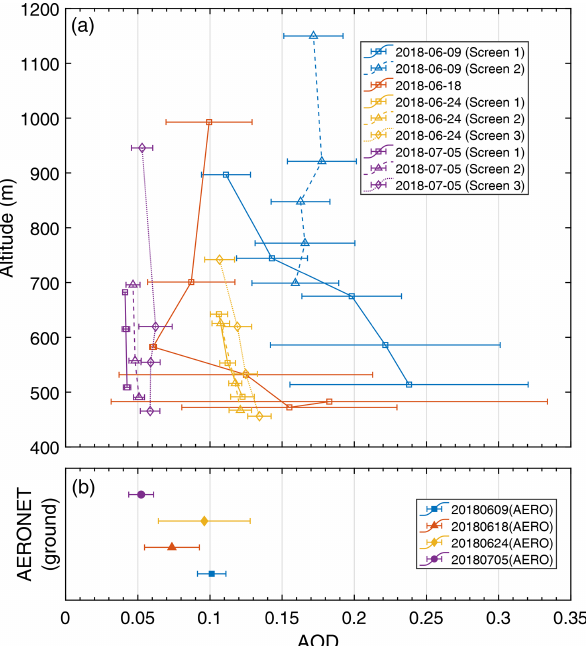
Figure 8. (a) 4STAR in-plume mean fine-mode AODs for transfor- mation flights of 9 and 24 June and 5 July and an emission flight of 18 June. (b) Fort McMurray ground-based AOD daily averages and standard deviations for selected dates (staggered vertically to show the error bars). In (a, b) the horizontal error bars indicate the AOD standard deviation representing spatial variability of the plumes (per altitude SD values for 4STAR and daily SD values for AERONET). For 24 June the AERONET data after 18:13 was removed because it was associated with forest fires.